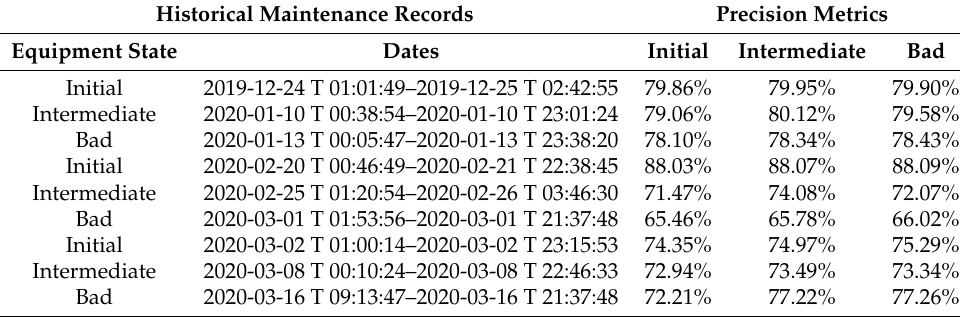
Table 4. LSTM-autoencoders precision metrics.